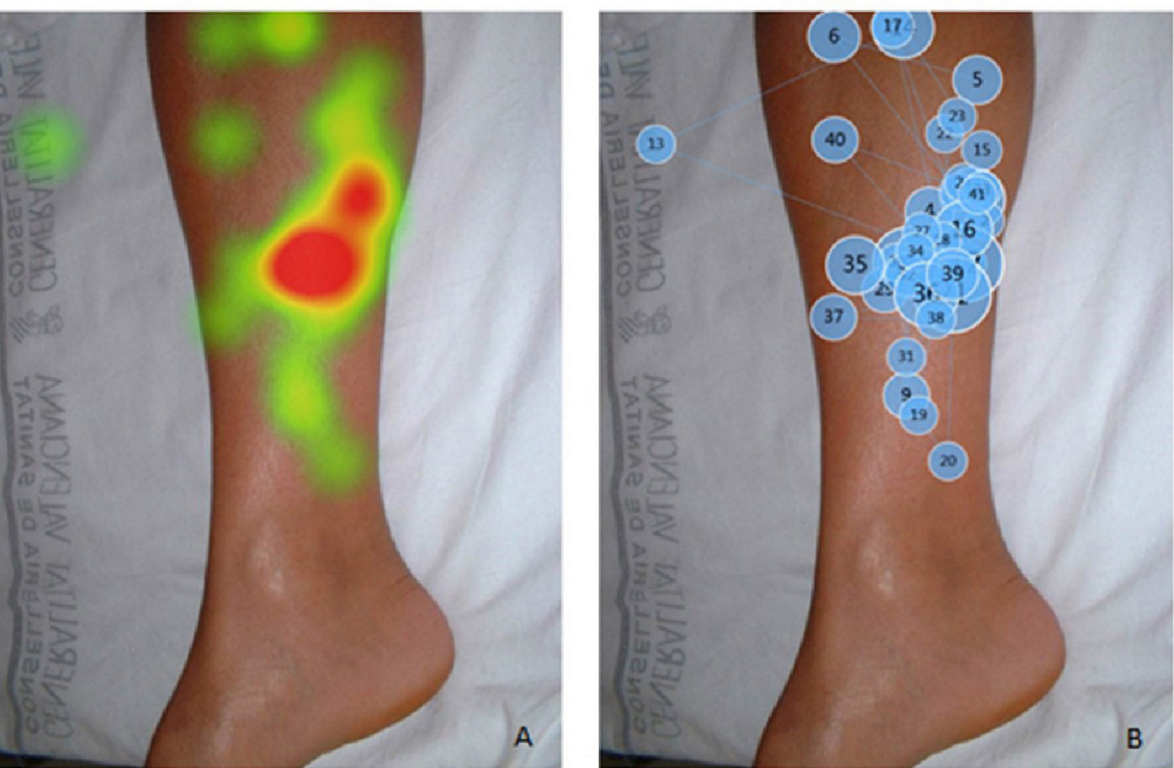
Figure 4. The time spent and location of gaze by the medical student looking at an image of skin lesions on a lower limb.